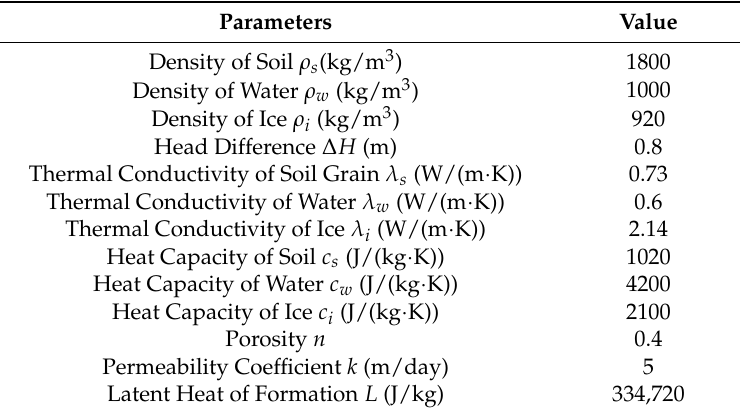
Table 2. Parameters used for engineering